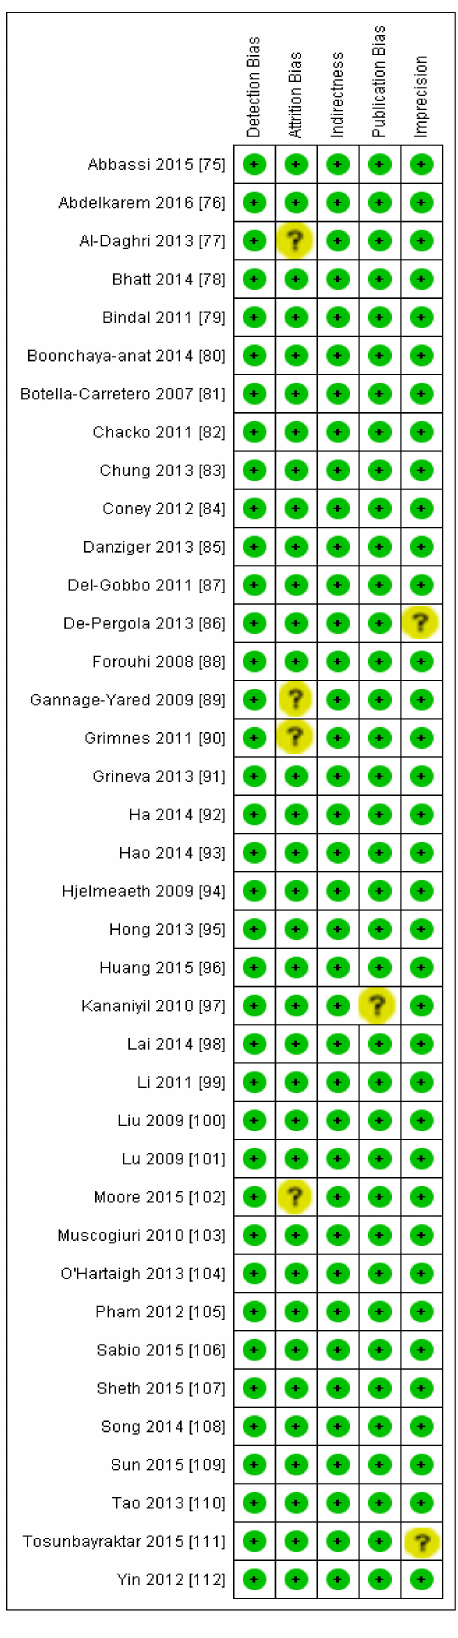
Figure 8. Risk of bias summary, data shown for individual studies (plus sign shows low ROB and question mark shows unknown ROB)